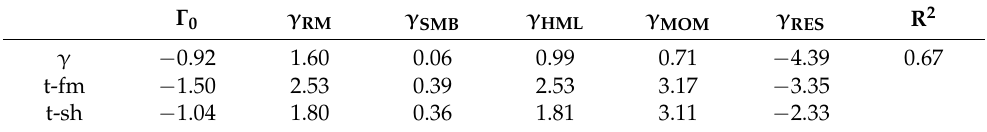
Table 13. Fama–MacBeth test on 25 size and momentum portfolios with the five-factor model. Results represent monthly percent returns from January 1981 to December 2015. The first four factors are the cross-sectional pricings of the four factors of the Carhart (1997) four-factor model, and γ RES is the pricing of R G ⊥ , the orthogonalized portion of the gold return against the Carhart four factors. t t-sh represents the Shanken (1992) error-in-variables corrected t-statistics. We adopt the Ferguson and Shockley (2003) methodology to derive this factor, adding the alpha and the residual from the time-series regression: R Gold t